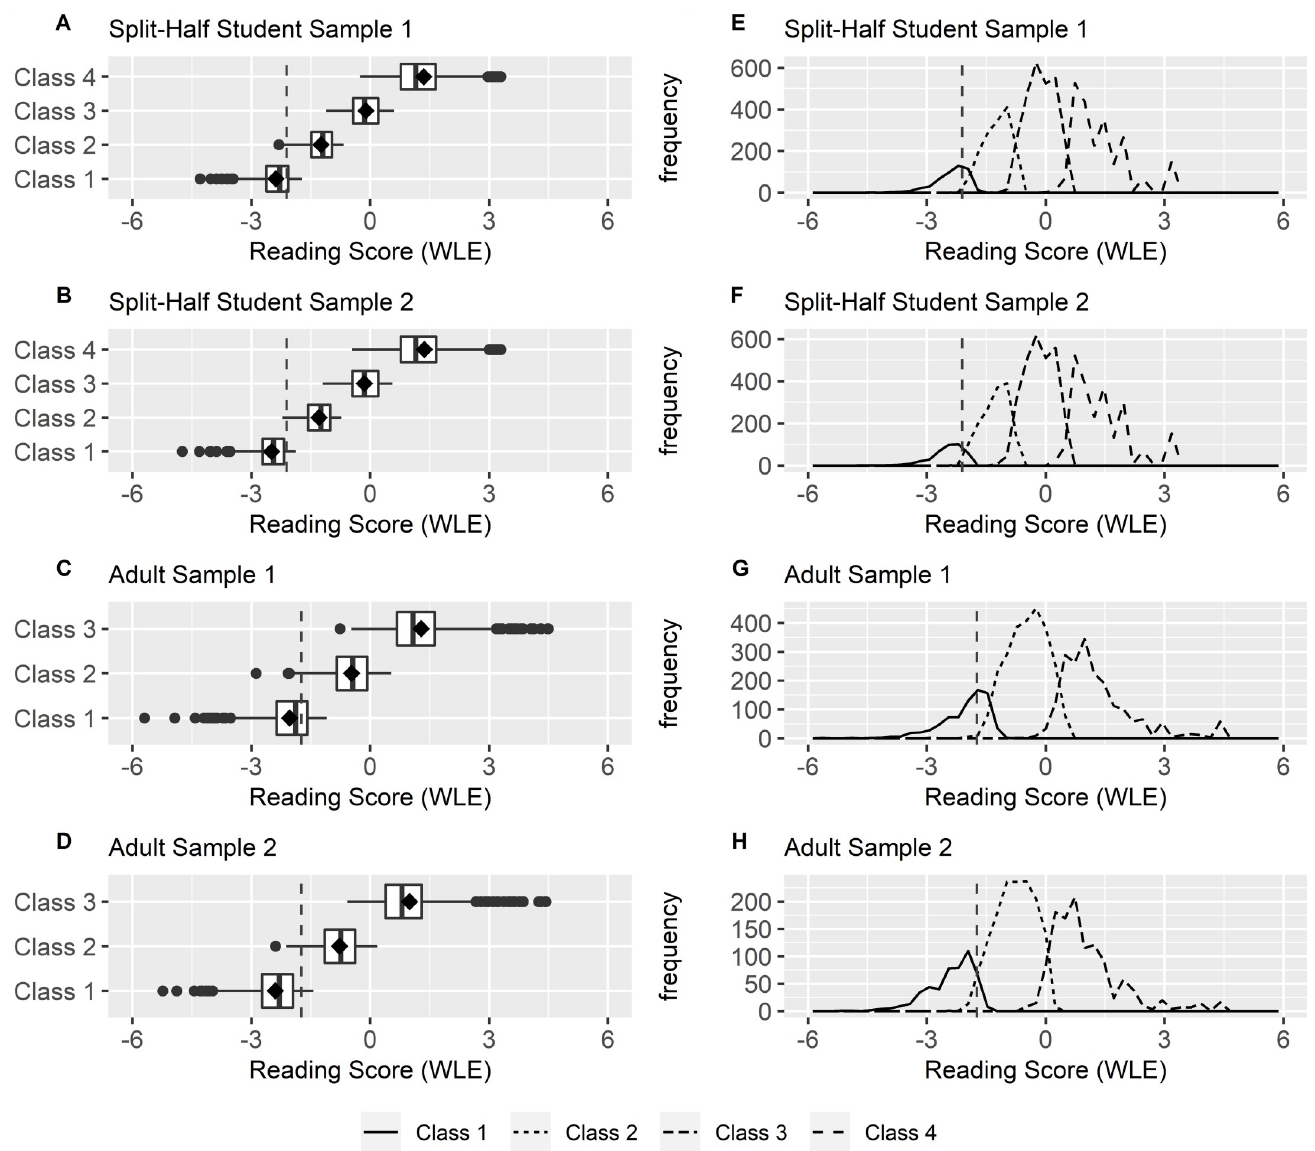
Fig 4. Distributions of the latent classes on reading score (WLE) in different samples. Boxplots in Fig 4A to 4D display the class-specific reading competence distribution for the different samples. Frequency polygons in Fig 4E to 4H display the class-specific reading ability distribution and frequency for the different samples. The dashed vertical lines mark the cut scores for the Bookmark procedure.